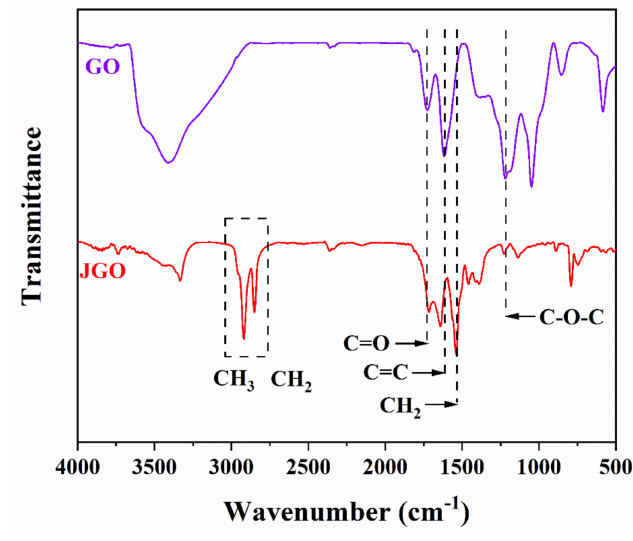
Figure 1. FTIR spectra of GO and JGO.